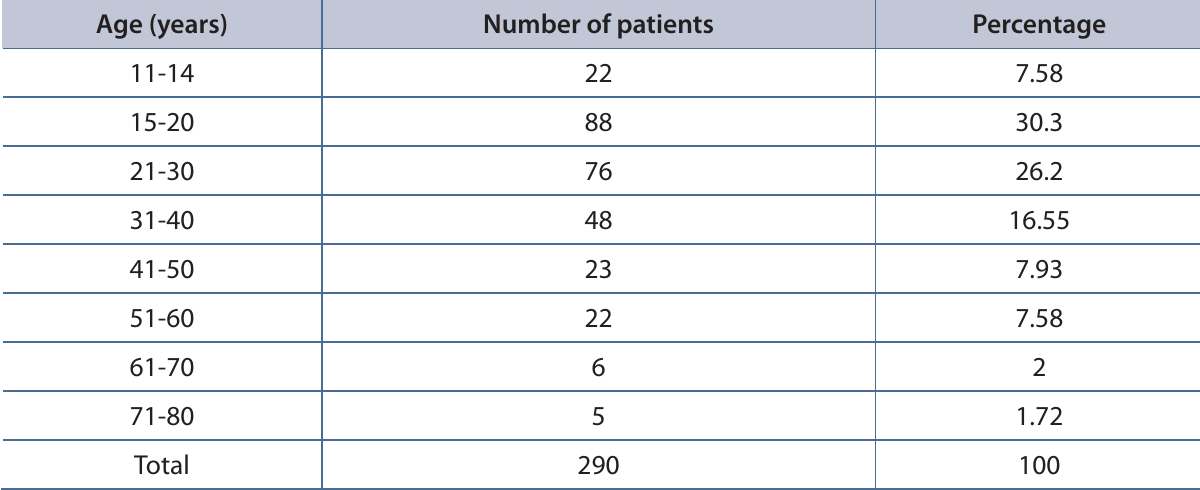
Table 1. Age distribution of 290 cases of adult patients stung by scorpions in Khuzestan, Iran Age